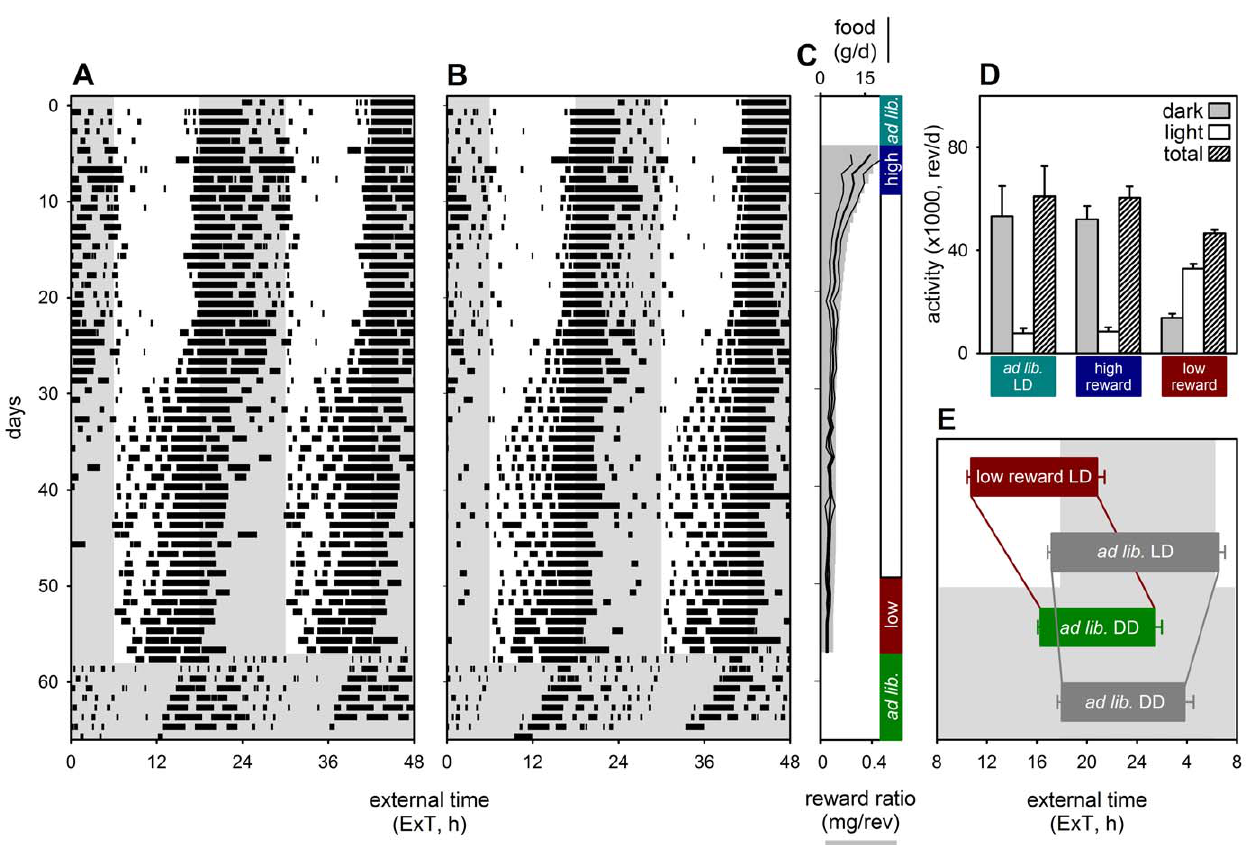
Figure 1. Low food reward ratio induces diurnal activity, with minor effects on daily activity levels and circadian pacemaker phase. ( A, B ) Two example actograms show the gradual shift from nocturnal to diurnal wheel running. ( C ) Gradual reward ratio reduction (grey bars) reduces total food obtained (line, in g/d; thin lines indicate s.e.m.). ( D ) Total activity per 24 h was slightly reduced but shifted largely to the day when the reward ratio was reduced (red compared to blue and cyan). The immediate shift to the previous dark phase after release in DD with ad libitum food indicates normal entrainment of the circadian pacemaker to the previous LD cycle ( A, B ; days 59–66). ( E ) Average activity onsets and offsets for working mice during the last 8 days under LD (red bar) and first 8 days in DD (green bar), and for the ad libitum control mice (grey bars) during the same time intervals.